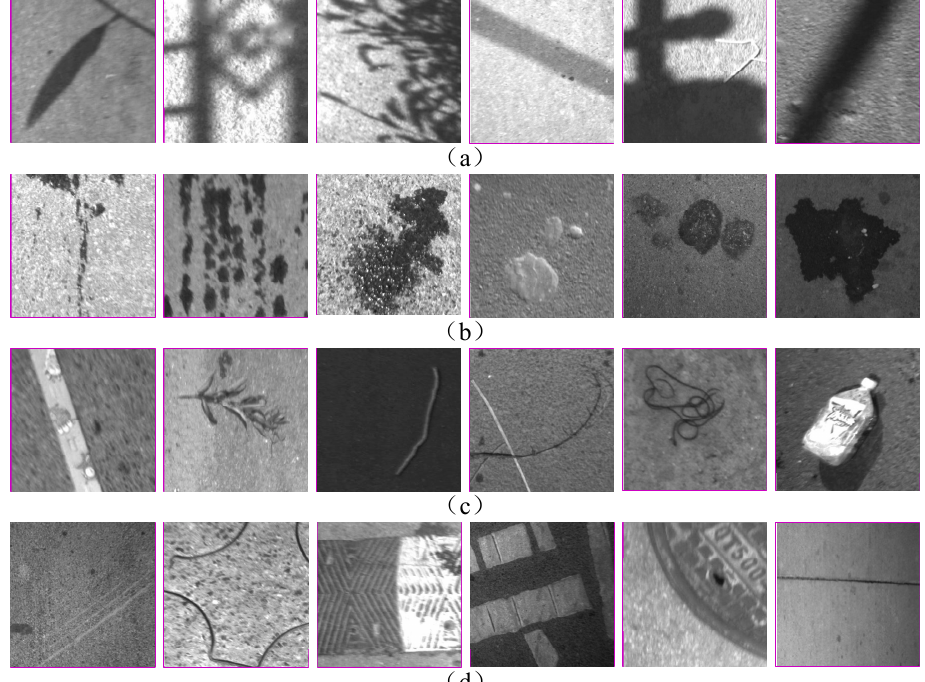
Figure 5. Negative samples from the ISTD-PDS7 dataset. ( a ) Under the in fl uence of interference, such as trees, light poles, and acquisition equipment, shadows appear in pavement images, leading to deviations in the overall gray-level distribution of the image. Some shadows have similar structural characteristics to the patch, but the roughness of the patch is greater than that of strip shadows; ( b ) Water stains, oil stains, mud stains, and other interference noise, some of which are